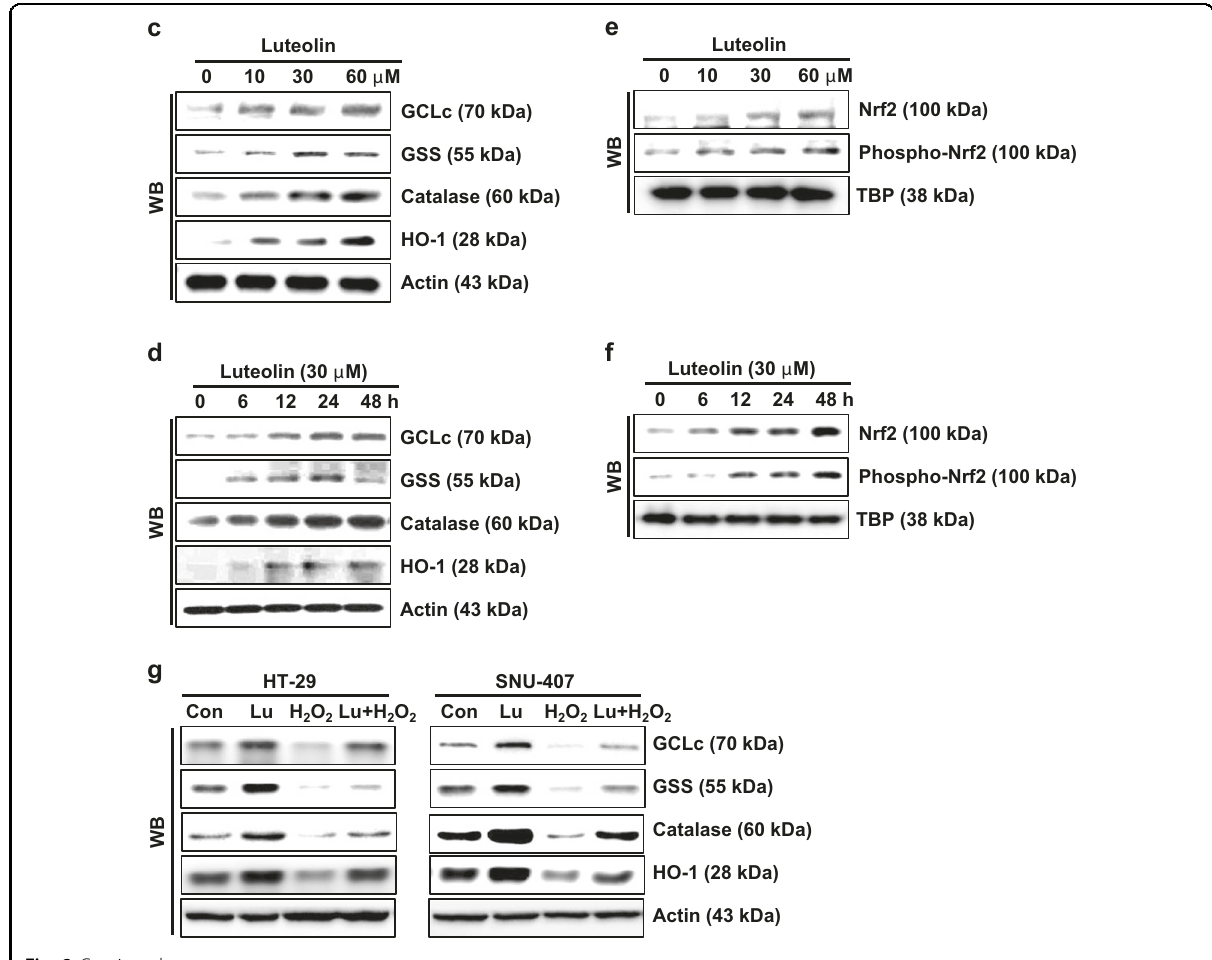
enzymes 23 . To con fi rm this, we evaluated intracellular ROS by staining HT-29 and SNU-407 cells with DCF-DA. Flow cytometric analysis demonstrated that the percen- tage of luteolin-treated cells stained with DCF-DA was signi fi cantly lower than the percentage of control